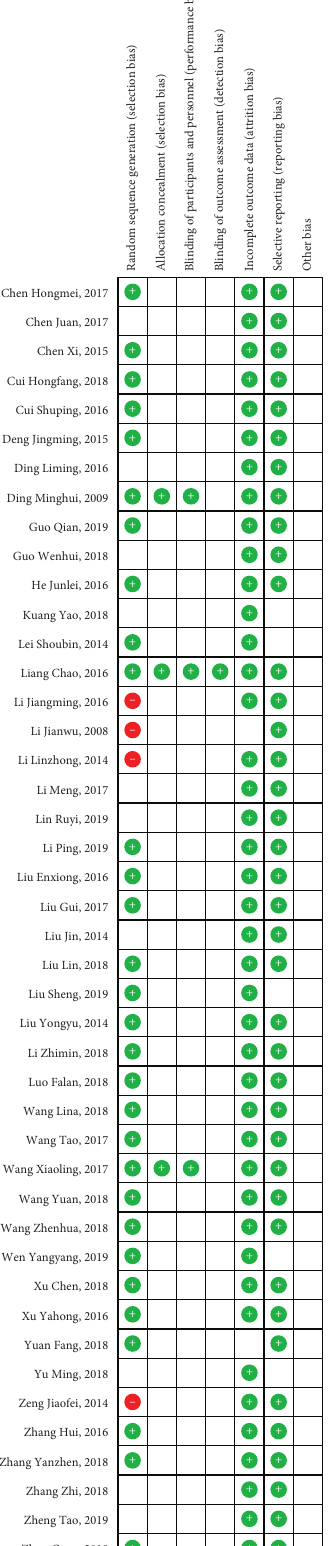
Figure 3: Risk of bias assessment in eligible studies. The quality assessment was conducted by Review Manager 5.3 according to Cochrane Handbook for Systematic Reviews of Interventions Version 5.1.0. Red circle, high risk of bias; green circle, low risk of bias; blank, unclear risk of